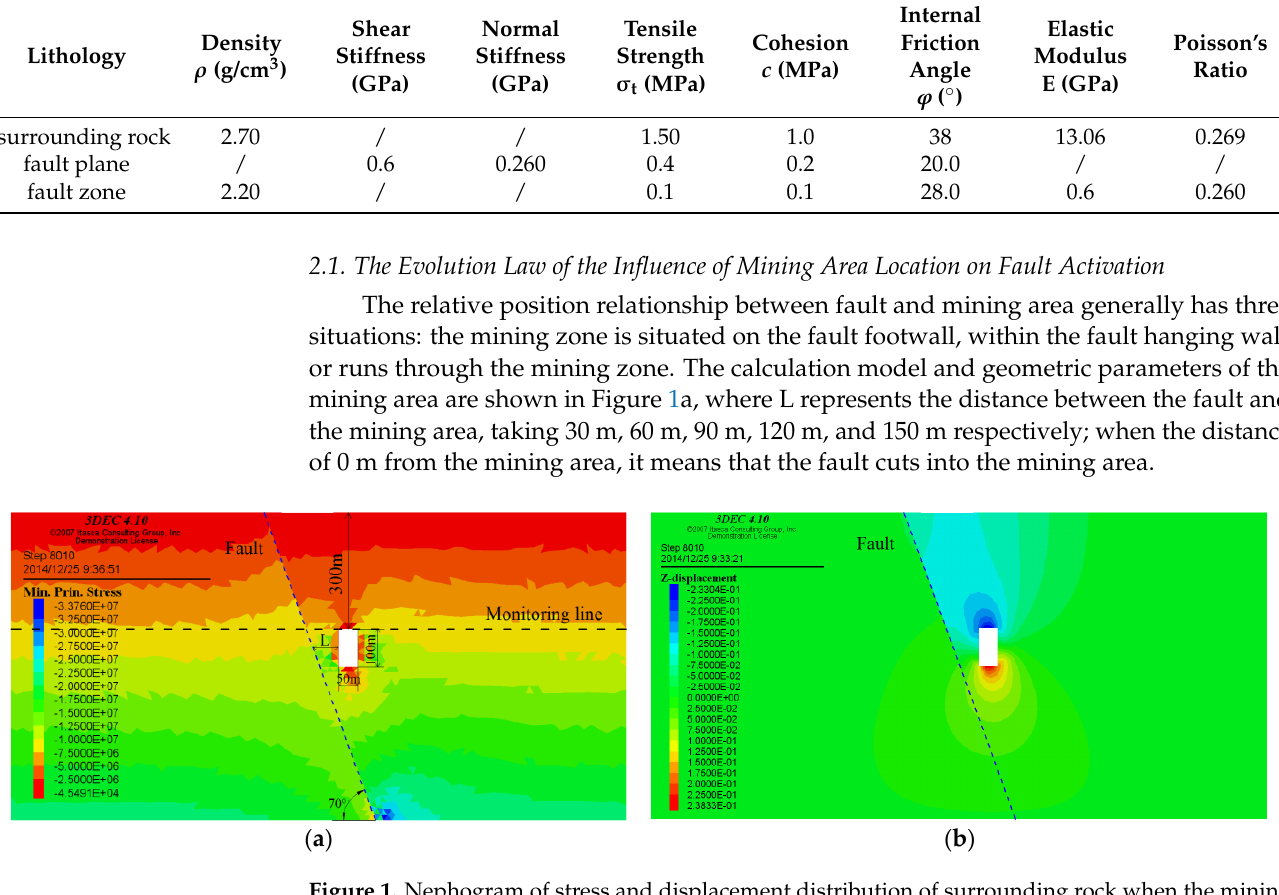
Table 1. Parameter table of Numerical simulation calculation.